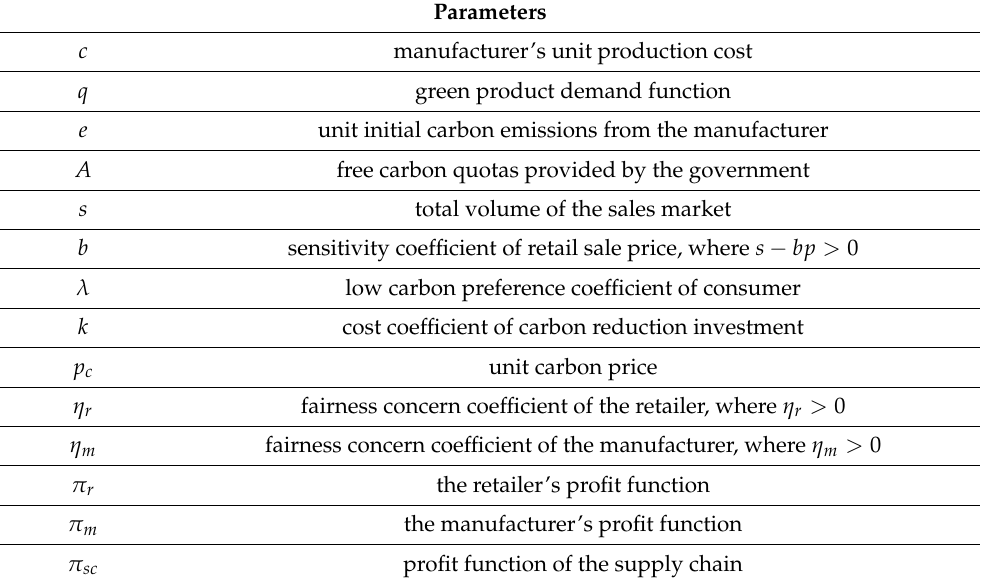
Table 1. Parameters and decision